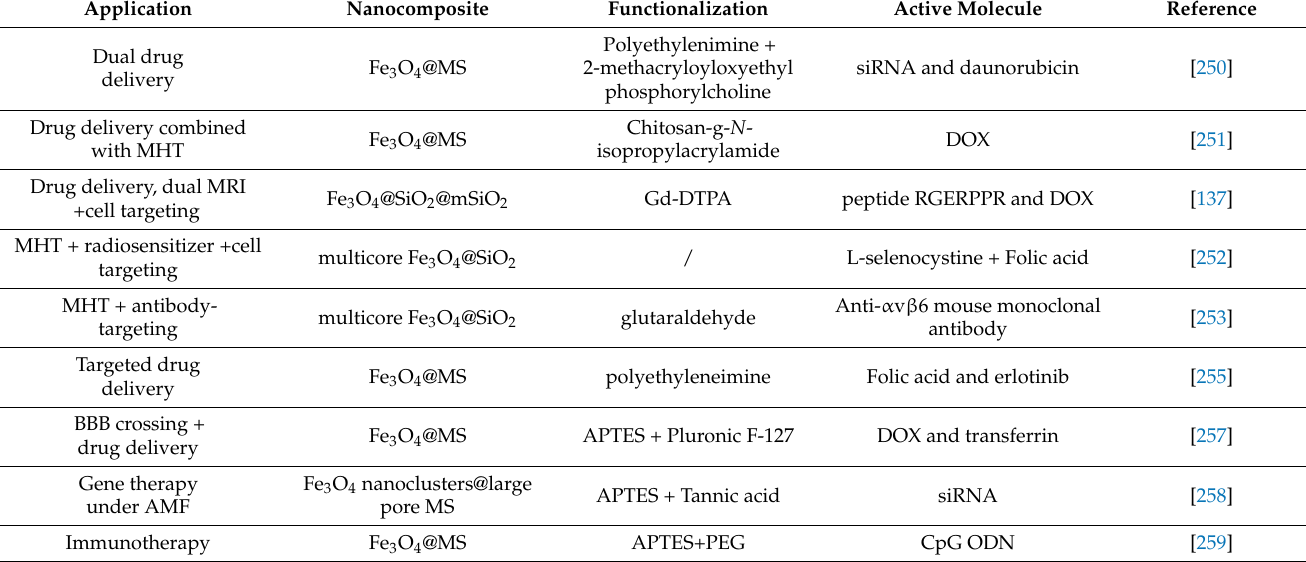
Table 1. Table summarizing IO@MS NPs used as different multimodal